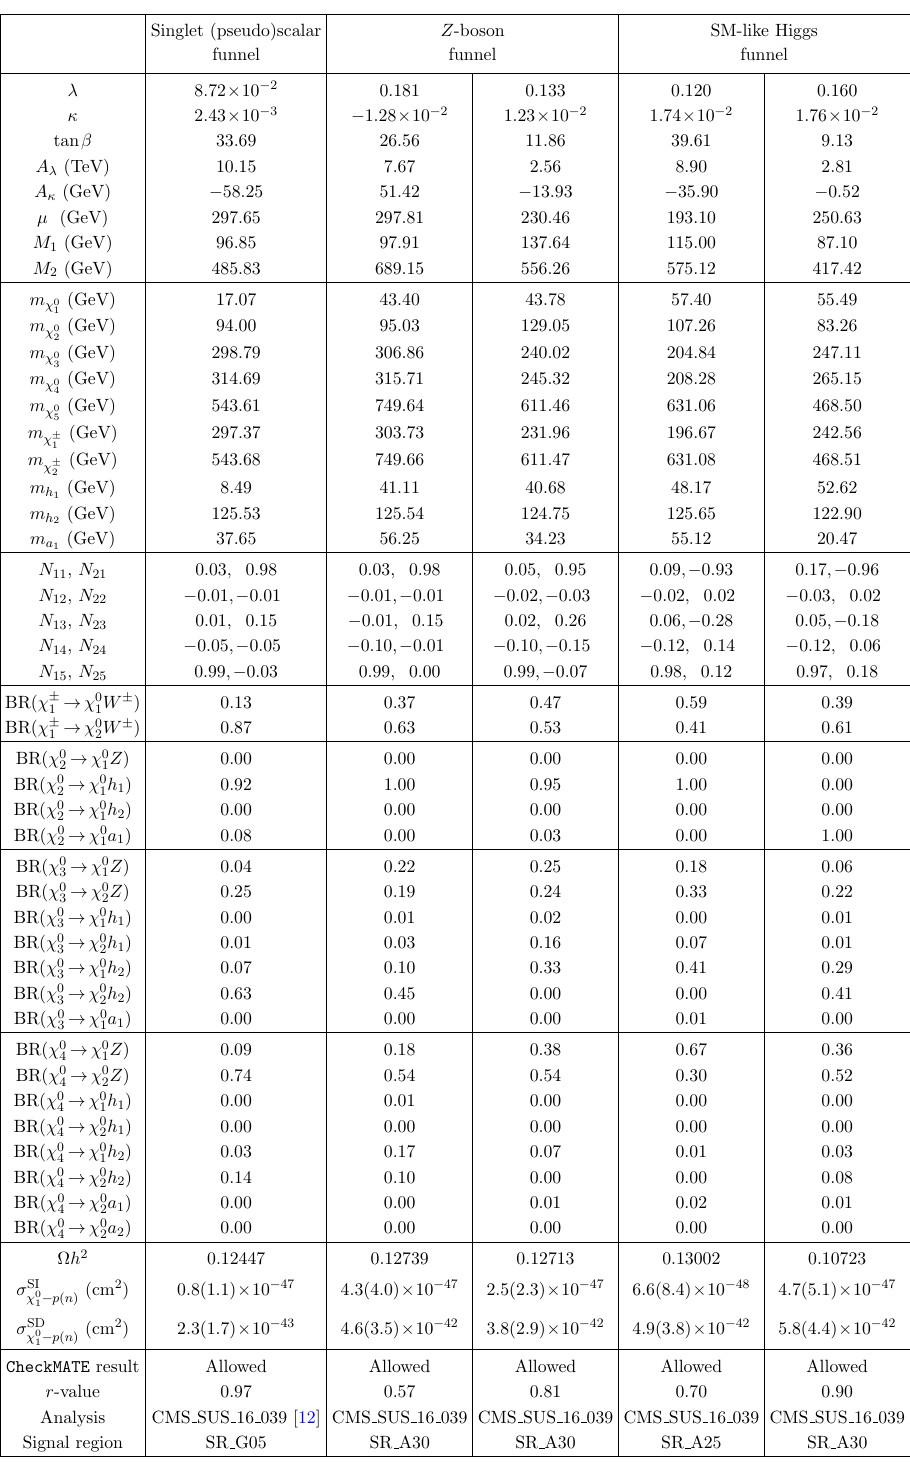
Table 2 . Benchmark points in the Z 3 -symmetric NMSSM parameter space o(cid:11)ering di(cid:11)erent annihilation-funnels for a singlino-dominated DM neutralino along with resulting spectra, composi- tions of the DM and the next-to-lightest neutralinos, various relevant branching fractions of the light ewinos, the values of the DM relic density, the DMDD-SI and the DMDD-SD cross sections. Also in- dicated are the ‘ r ’-values (see section 3.3) returned by CheckMATE along with the reference LHC ana- lyzes and the most sensitive Signal Regions (SR). NMSSMTools - v5.3.0 is used to generate the